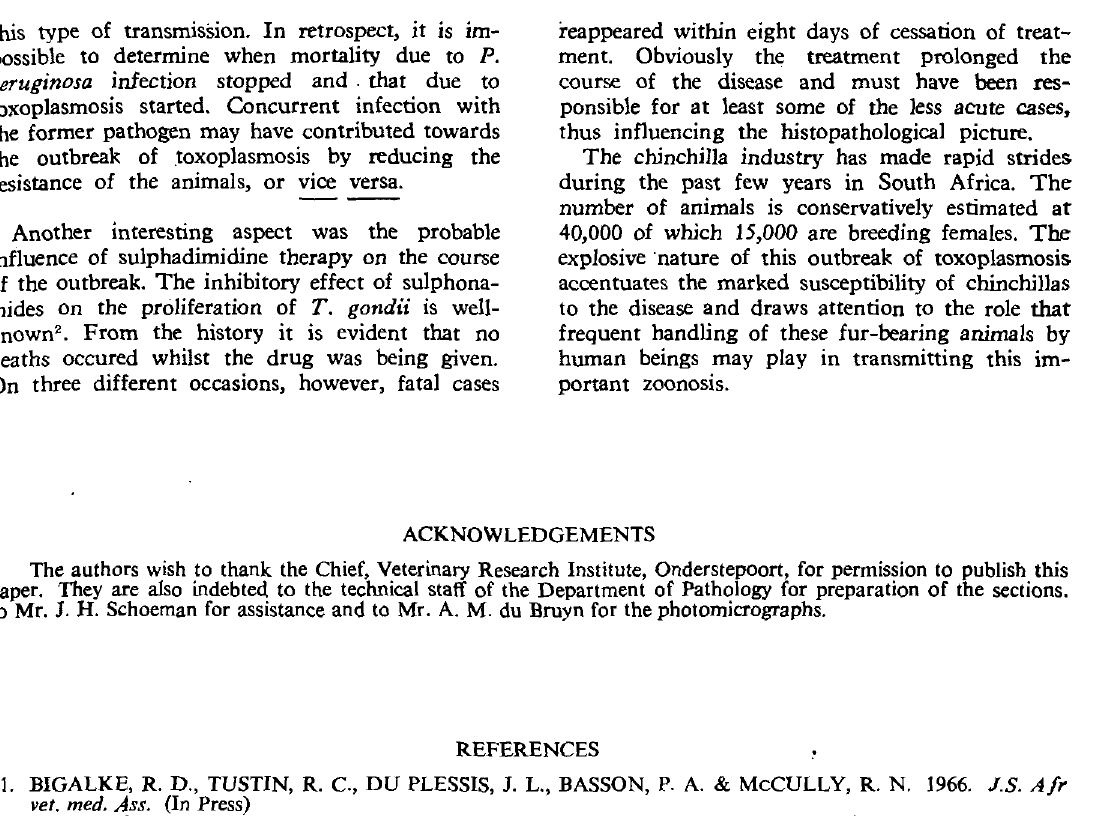
Fig. 1, A-G, lung. A. Lining of alveoli by activated alveolar macrophages and filling of alveoli by free macrophages and oe dema. H & E, X2OO. B. Higher magnification of A. H & E, X480. C. Free and intracellular Toxoplasma organisms in alveolus. Giemsa, X1200. D. Clump of organisms (1) and "ghost" forms (arrows) in free macrophages. Giemsa, X1200. E. Subacute focal pneumonia. H & E, X75. F. Higher magnification of parasitized macrophages in E. H & E, X1200. G. Thickening of alveolar walls in interstitial pneumonia of chronic (recovered) case. H & E, X480. H. Small necrotic focus in liver. H & E, X480.